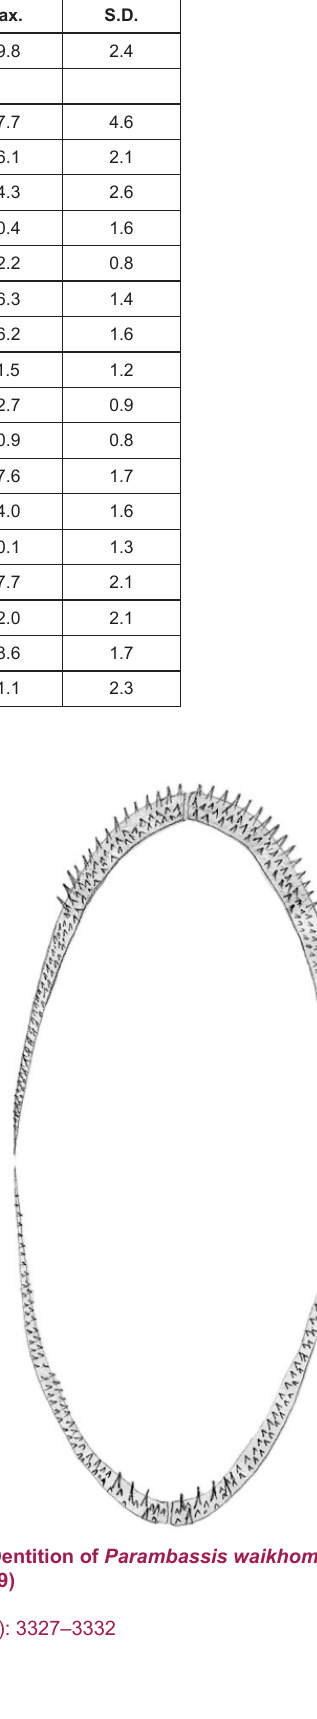
Table 1. Morphological characters of Parambassis waikhomi sp. nov. Characters